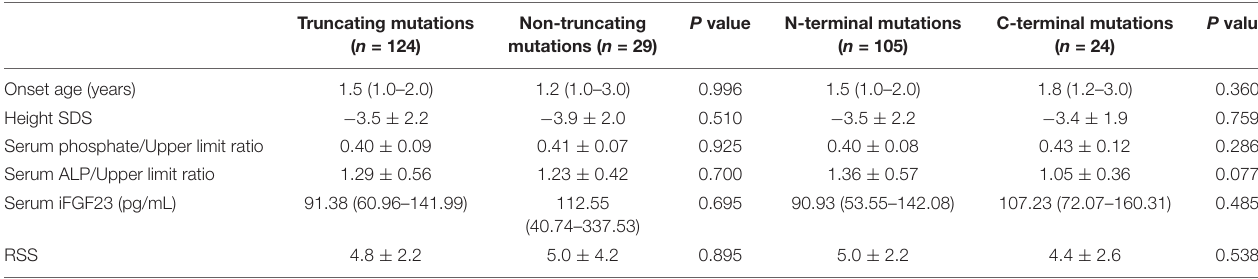
TABLE 5 | Genotype-phenotype correlation in patients with XLH.